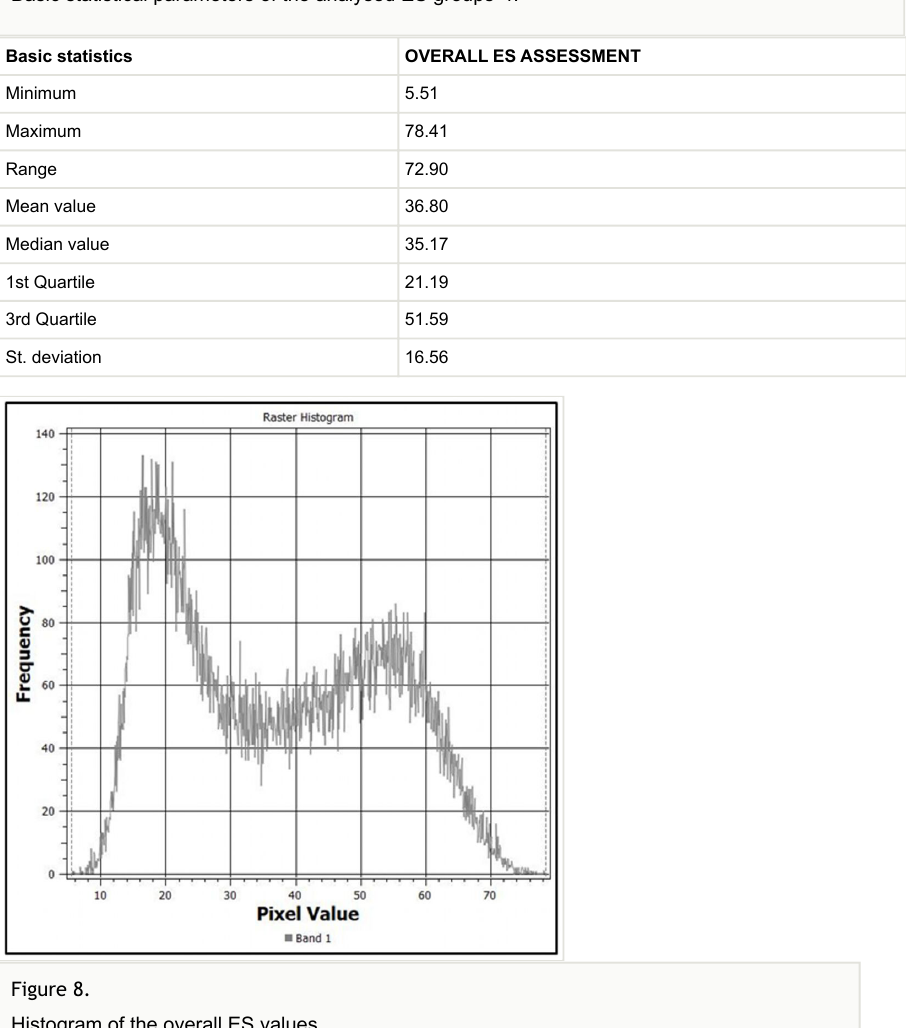
Histogram of the overall ES